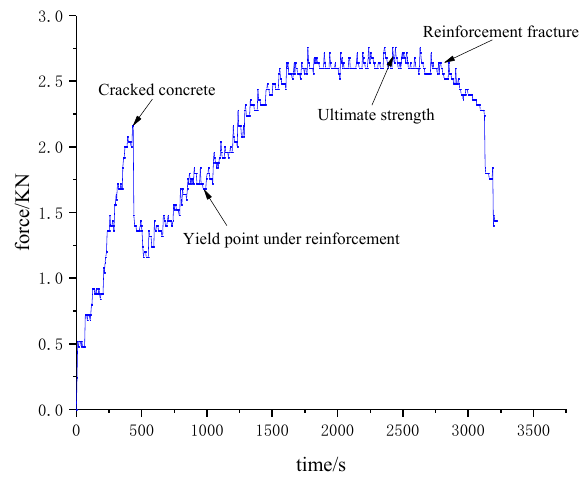
Figure 6. Force-time curves.